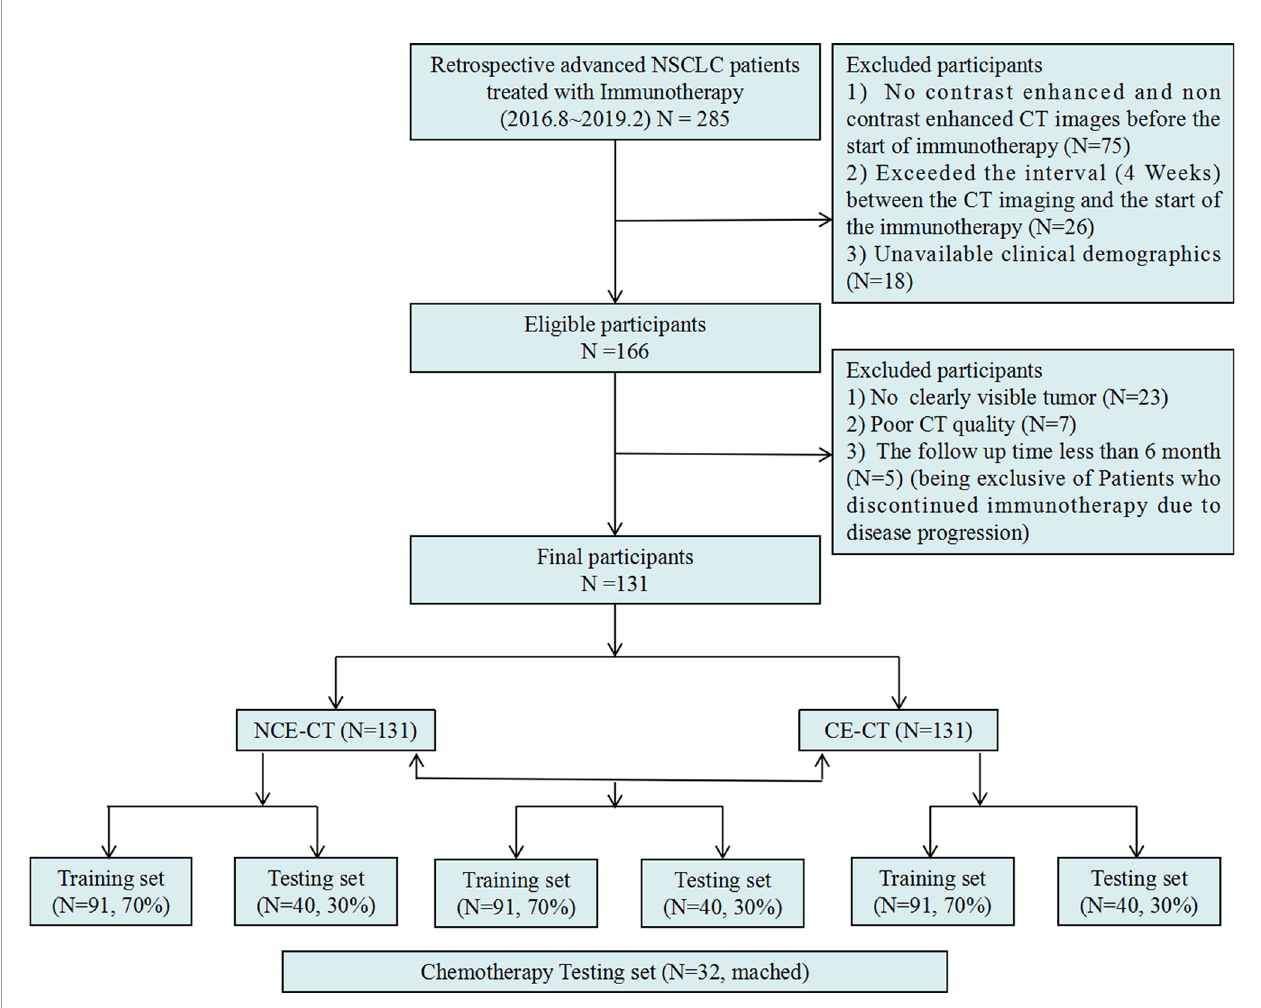
FIGURE 2 | Inclusion and exclusion diagram. Training and testing sets were randomly divided in a proportion of 7:3 respectively as